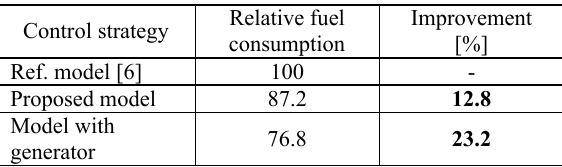
Relative fuel consumption